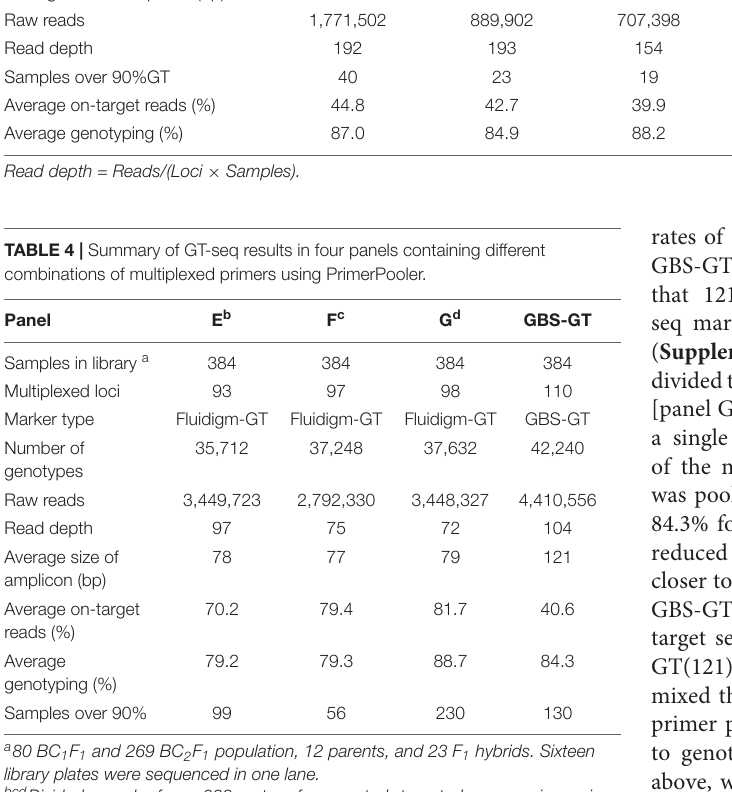
TABLE 3 | Summary of GT-seq results in seven panels containing different numbers of multiplexed primers. Panel A B C D AB BC Samples in library